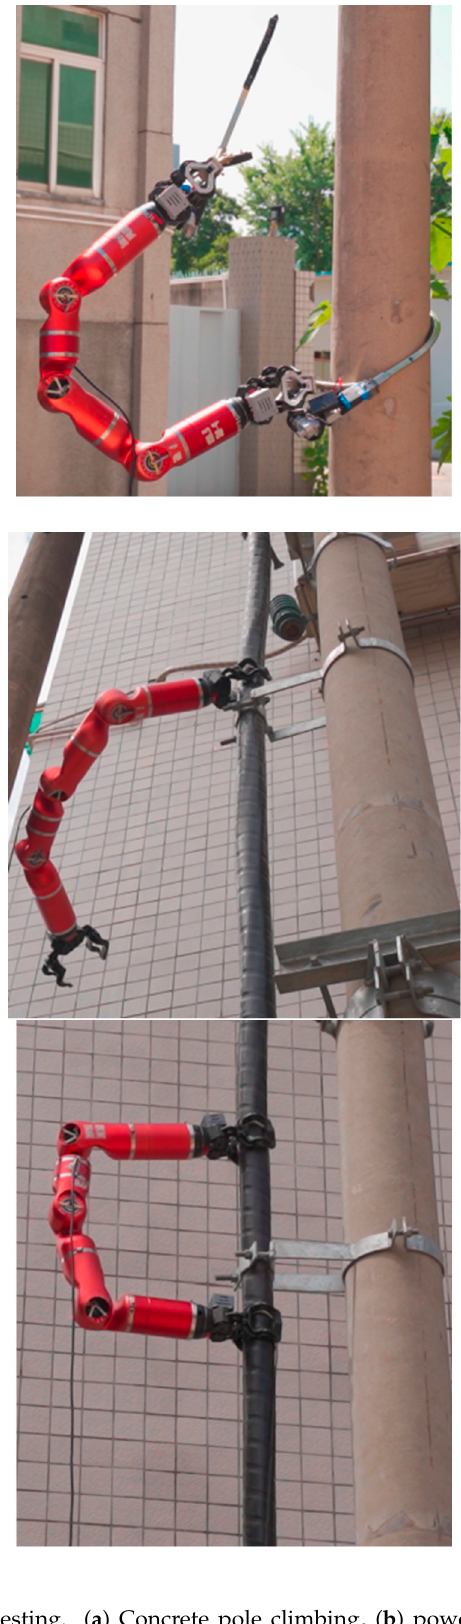
Figure 29. The robot climbs the pole for testing. ( a ) Concrete pole climbing, ( b ) power cable passage climbing.